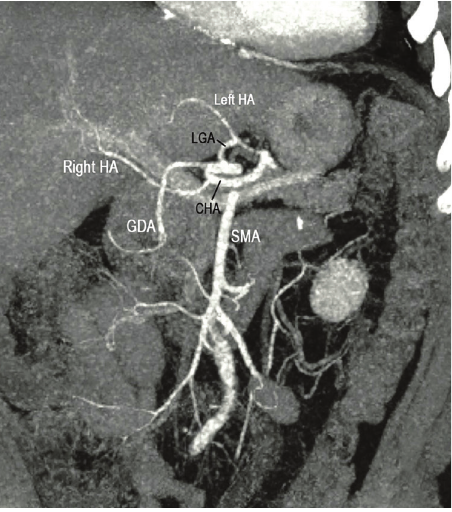
Figure 5 - Coronal plan CTA image shows a replaced left HA from LGA origin and right HA originating from CHA.